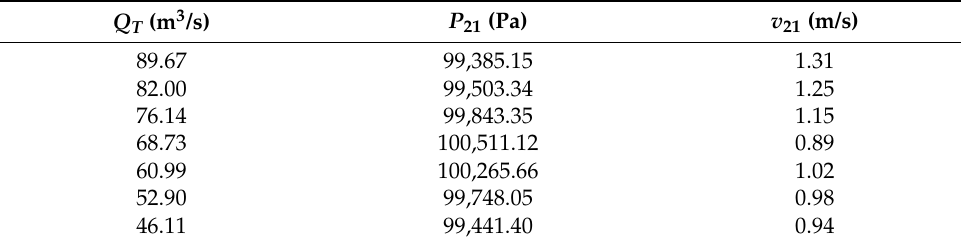
Table 9. Manifold ´ s velocity and pressure, low-pressure